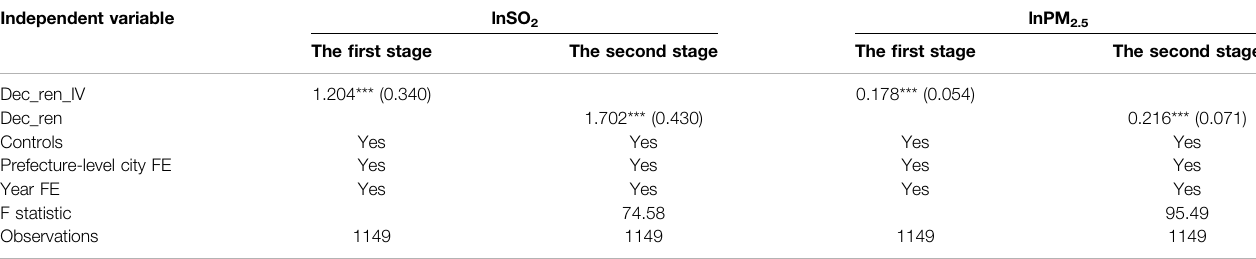
TABLE 5 | Endogenous analysis. Independent variable